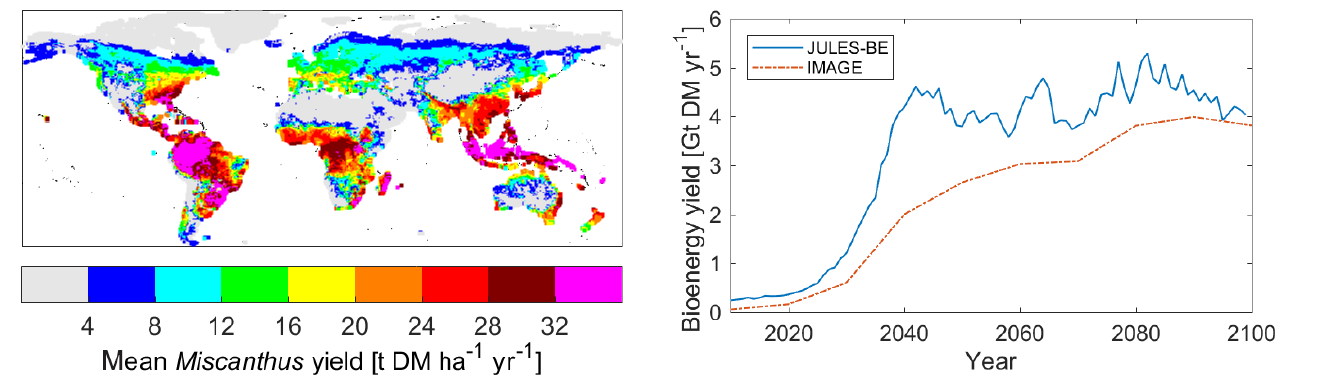
Figure 6. Modelled yields of the Miscanthus PFT, averaged over 2010–2019.